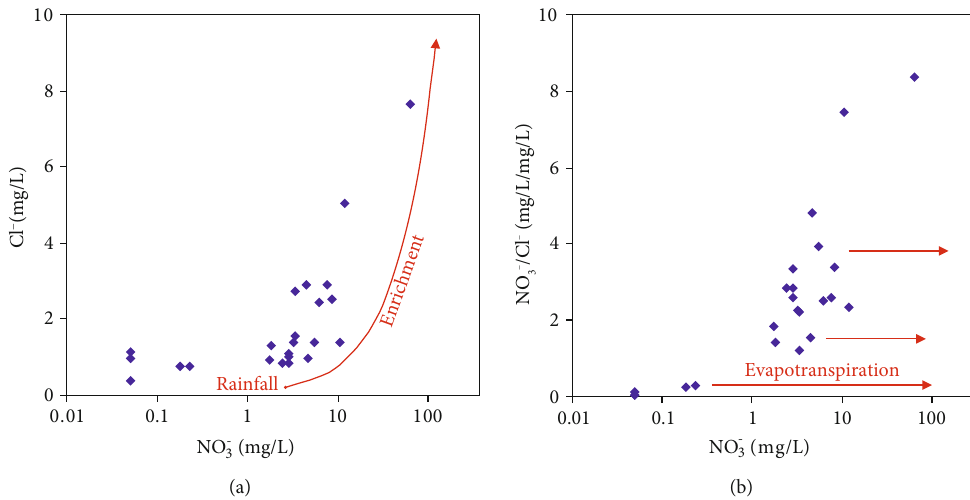
Figure 7: The relationship between NO 3- and Cl - for spring and evapotranspiration line for rainfall (a) and between NO 3- and NO 3- /Cl - (b). During evapotranspiration, NO 3- /Cl - would remain